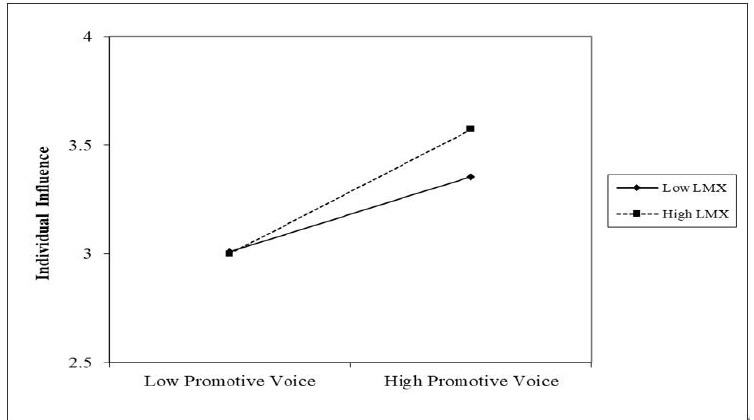
Figure 2. Two-way Interaction of LMX and Promotive Voice.